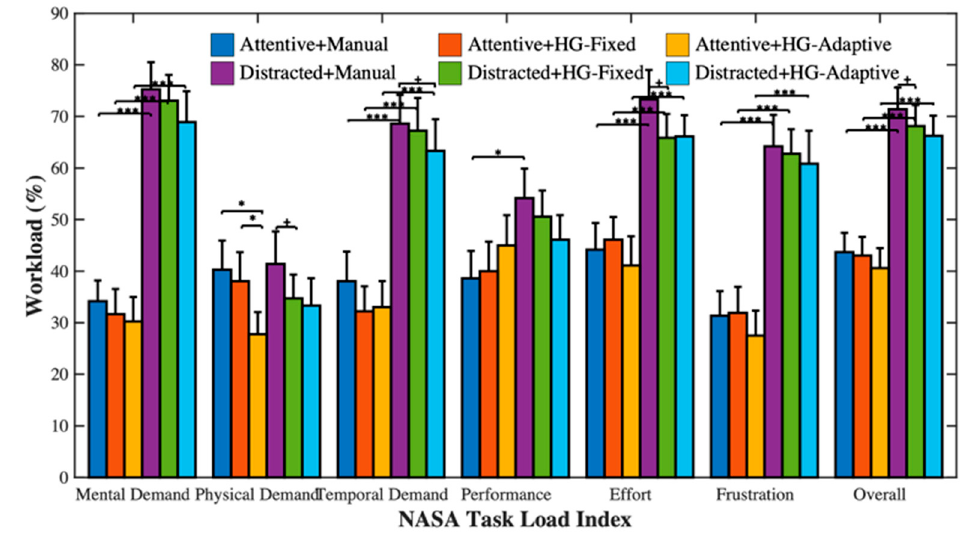
Figure 7. Mean scores on NASA-TLX. Data error bars represent the mean + SEM. + p < 0.1, * p < 0.05, and *** p < 0.001.